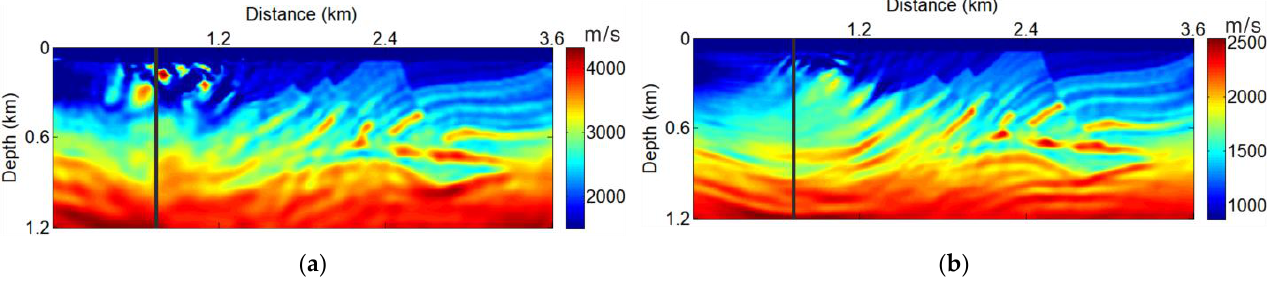
Figure 7. Conventional EFWI results with high-frequency data (5–15 Hz) using Figure 6 as the initial model; ( a ) V p ; ( b ) V s .